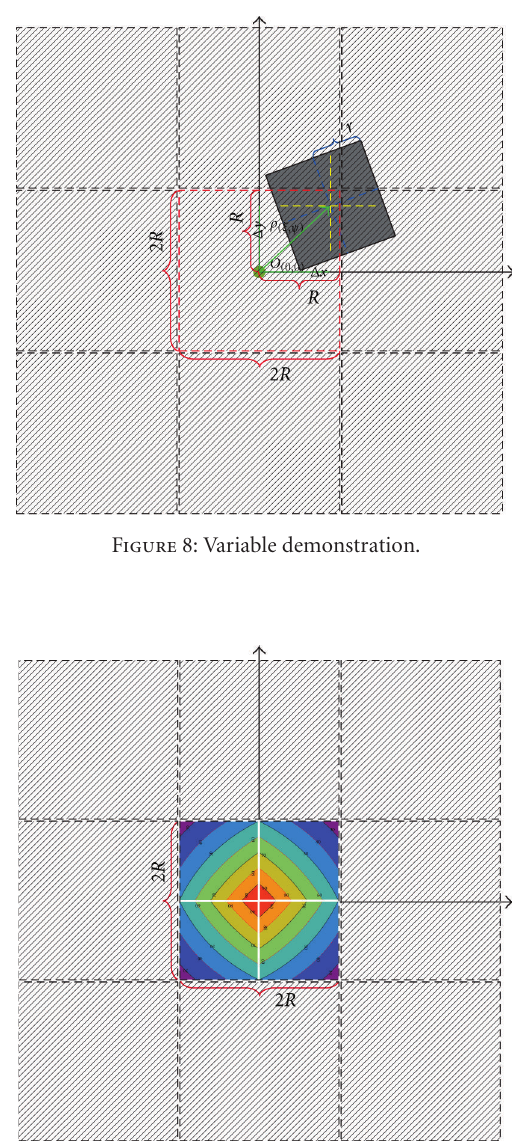
Figure 9: Pixel covered as function of target size for θ = 0, α = 2, and β =